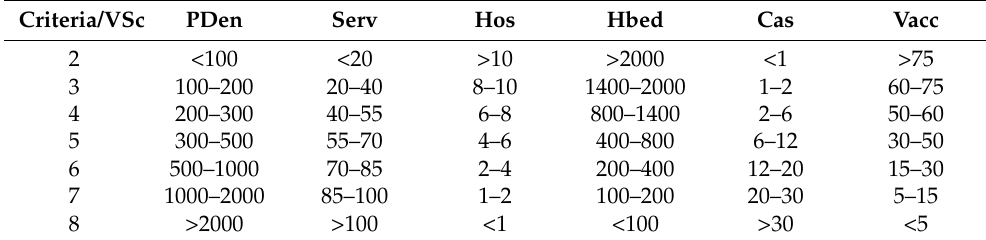
Table 4. The selected criteria scores (own study based on